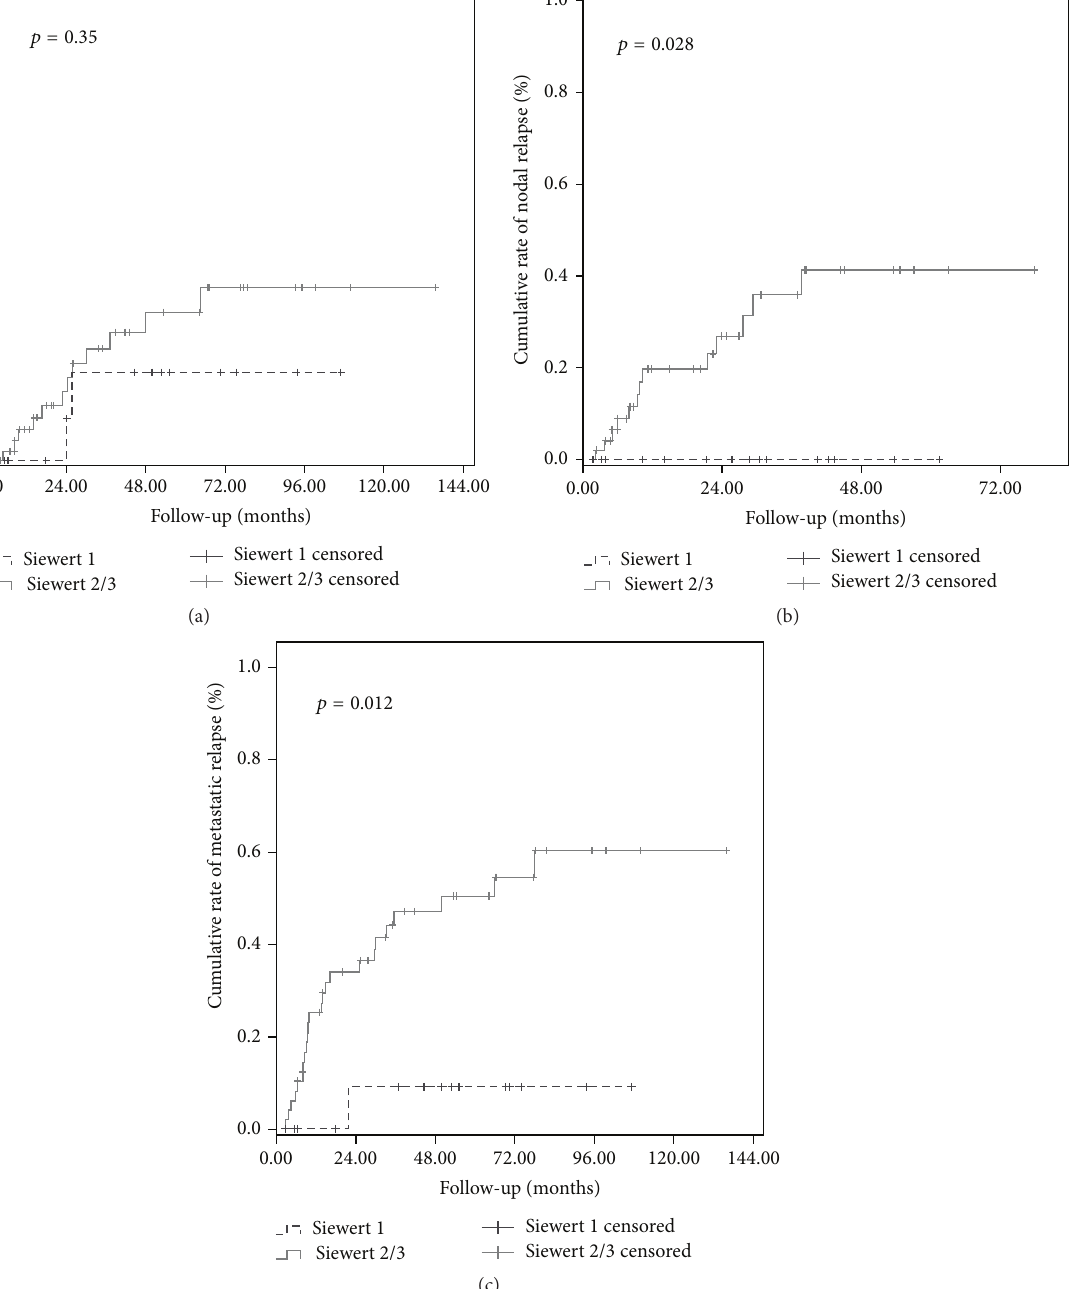
Figure 3: Cumulative rate of local recurrence (CRLR) (a), nodal recurrence (NRLR) (b), and metastatic recurrence (MRLR) (c) according to the Siewert classification (Siewert type 1 versus Siewert types 2 and